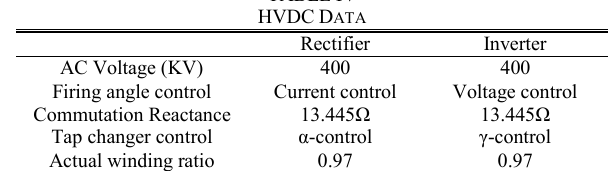
TABLE III T RANSFORMER TYPE